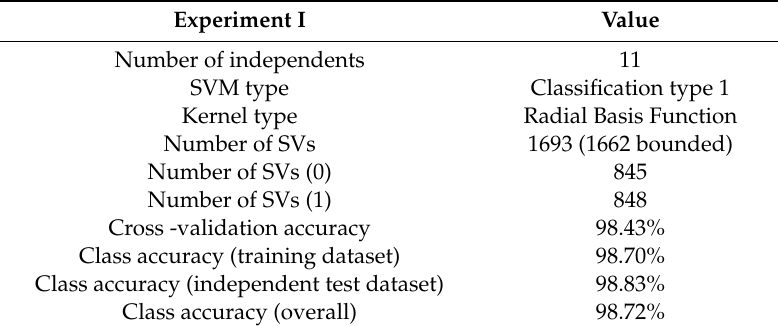
Table 2. Experiment I model summary ( ψ = 0.75, C = 2).